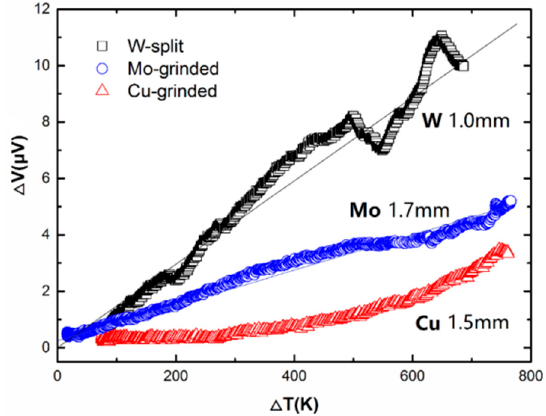
Figure 2. Measurement results of the voltage at the cold ends versus temperature for one splitting W sample (original diameter 1.0 mm), one grinded Mo sample (original diameter 1.7 mm), and one Cu sample (original diameter 1.5 mm).